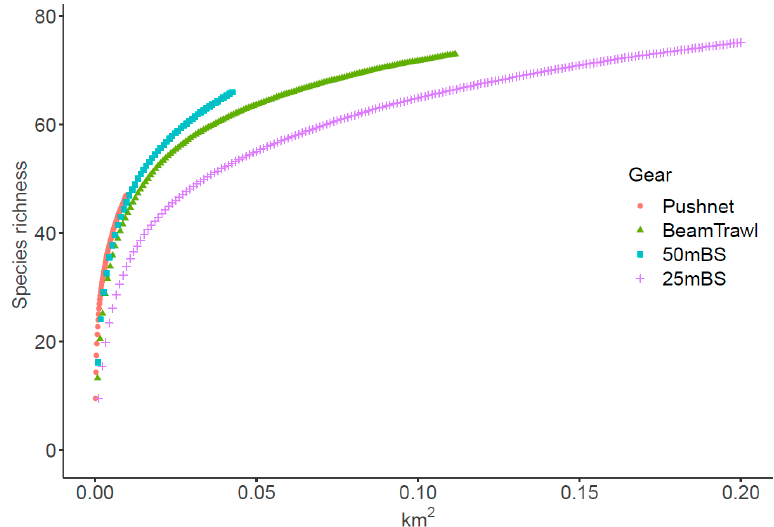
Figure 3. Species accumulation curves representing the number of species observed vs. sampled area, for 25-m beach seine (BS25), 50-m beach seine (BS50), beam trawl (BT) and Riley push net (RP). Each point represents one sample.